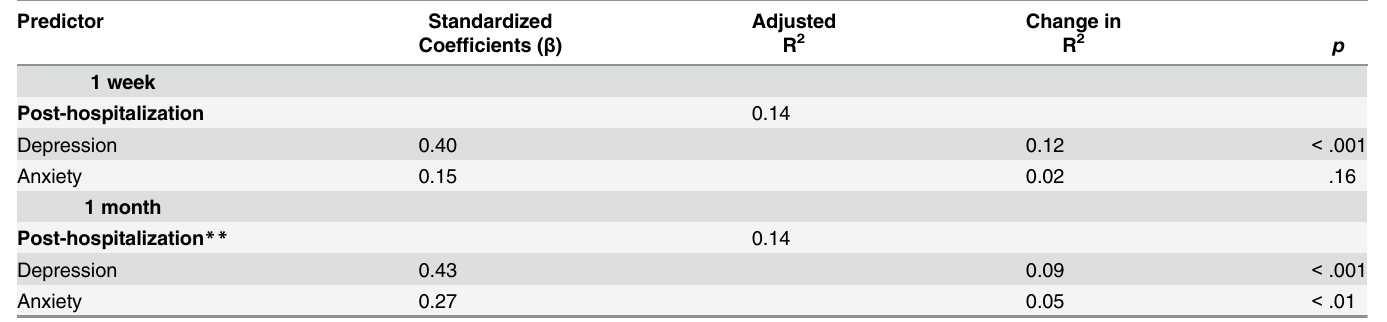
Table 6. Predictors of sleep quality between 1-week and 1-month post-hospitalization * .